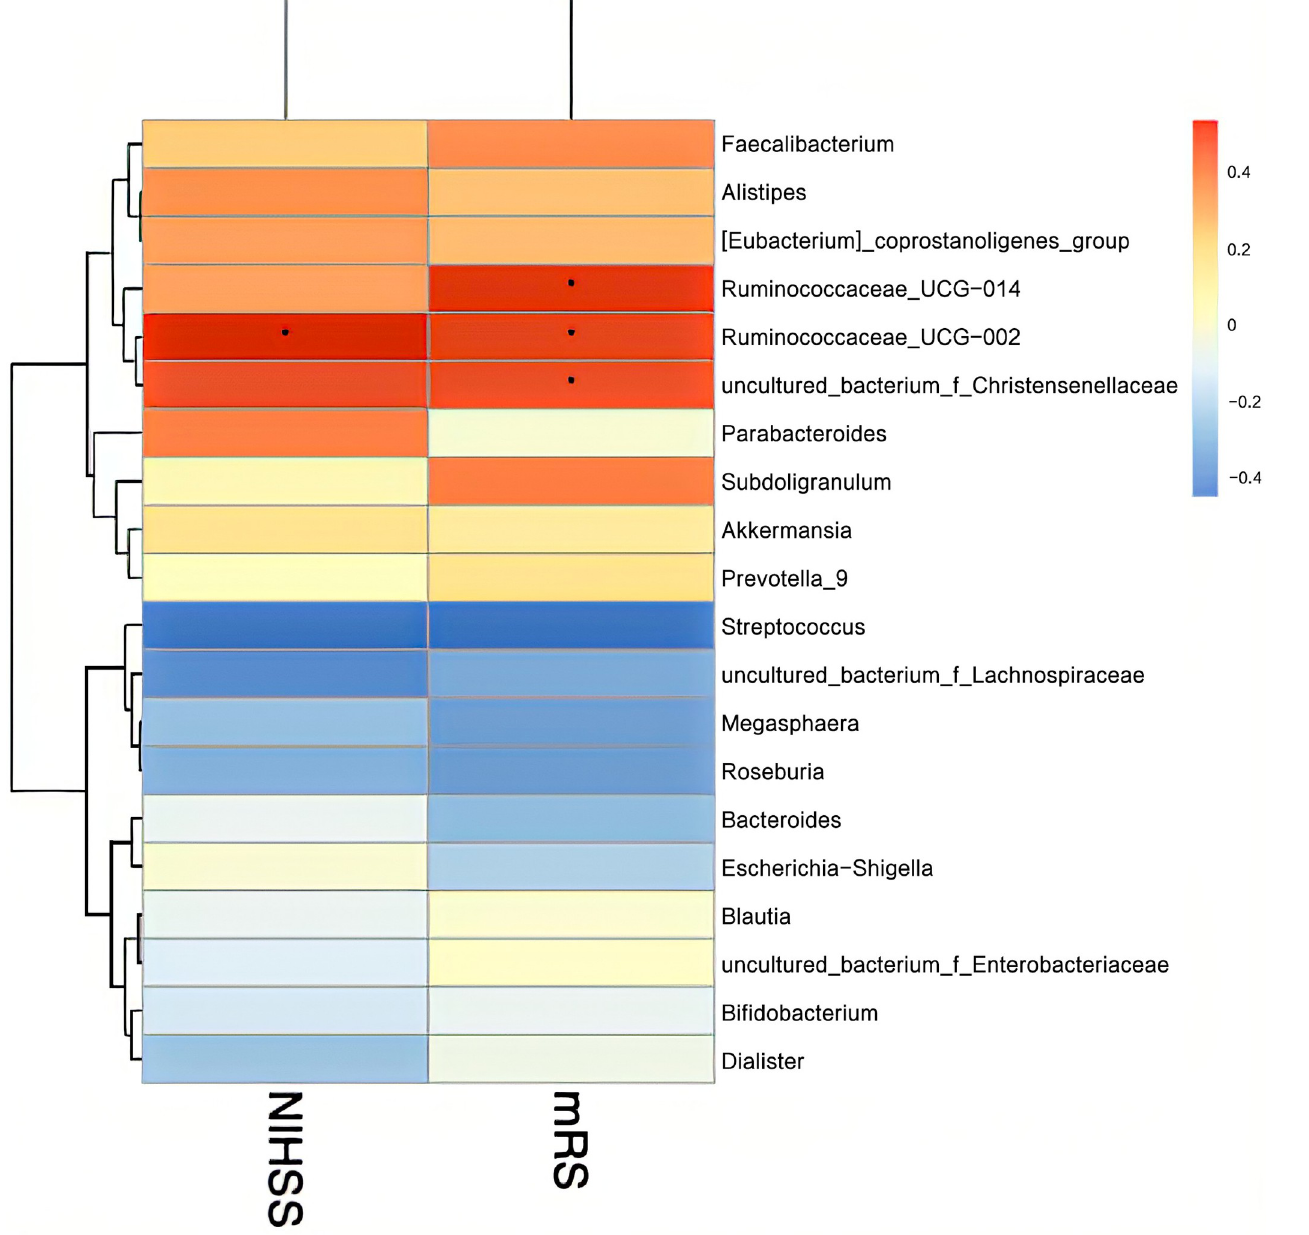
PLOS ONE | https://doi.org/10.1371/journal.pone.0276598 November3,